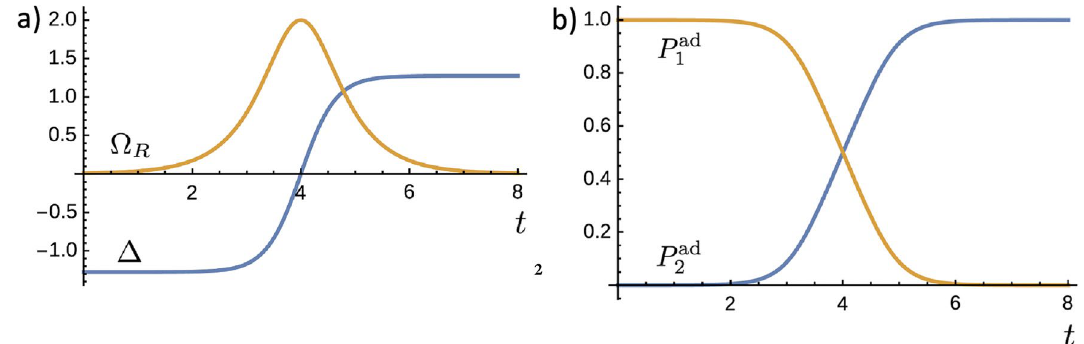
1 ( 0 ) n . Parameters: | � ≈ | � +